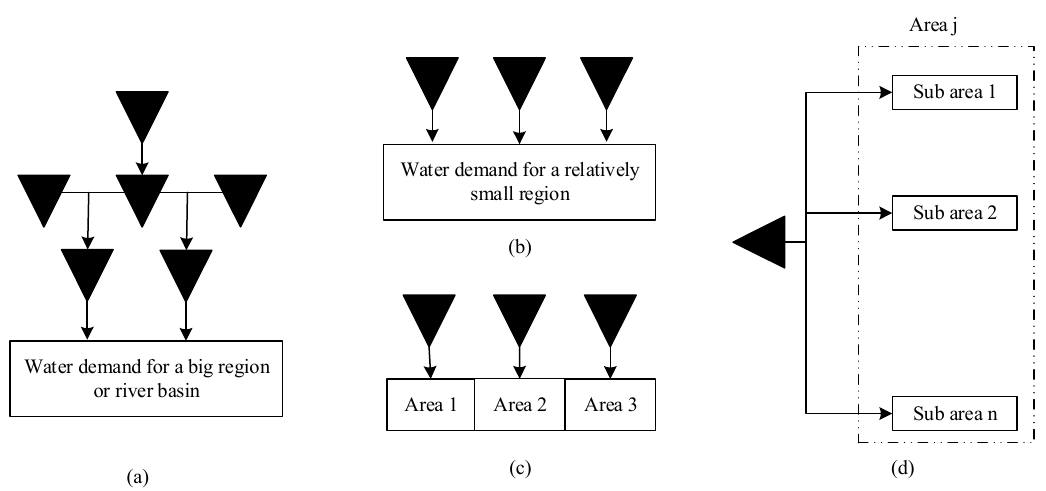
Figure 1. Reservoir topology structure. ( a ) Mixed-connected; ( b ) parallel; ( c ) based on ( b ), the small region divided into several areas; ( d ) the topology structure among sub-areas and reservoir.